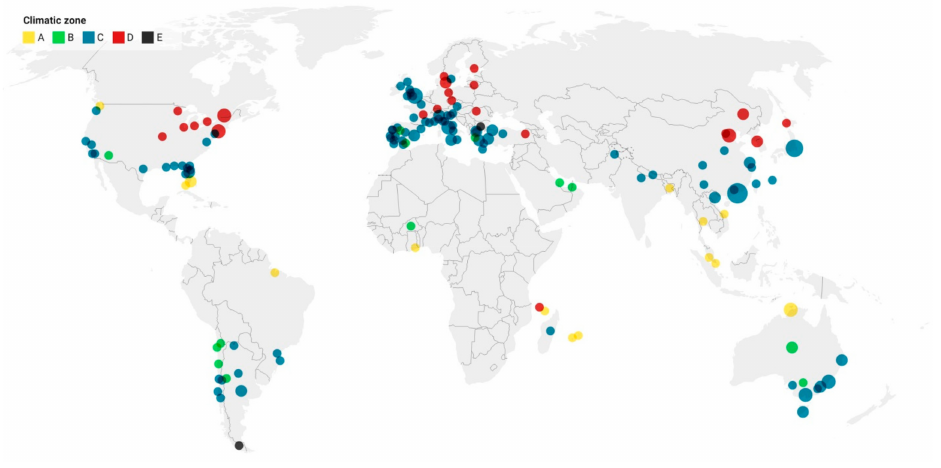
Figure 2. Overview of the investigated